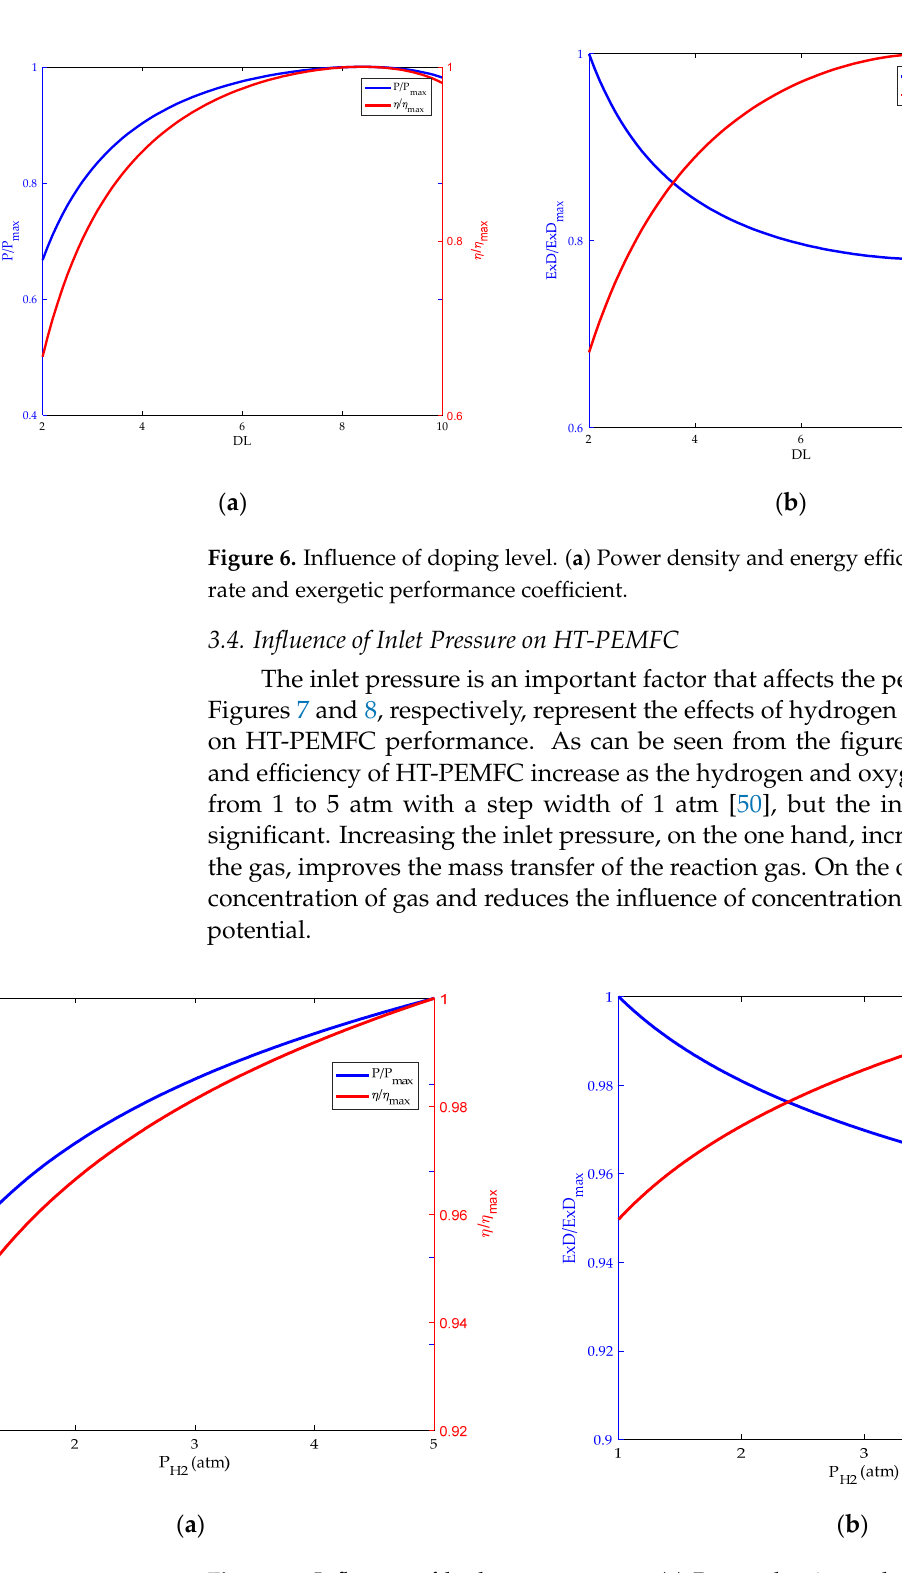
( b ) Figure 8. Influence of oxygen pressure. ( a ) Power density and energy efficiency; ( b ) exergy de- struction rate and exergetic performance coefficient.